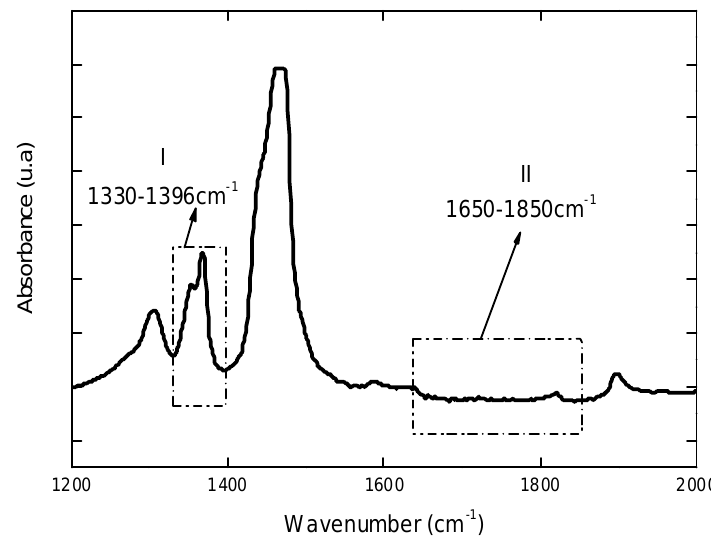
Figure 1. FTIR spectrum of reference UHMWPE in the region from 1,200 to 2,000 cm -1 used to estimate the total oxidation index (Iox) according to ISO 5834-4.